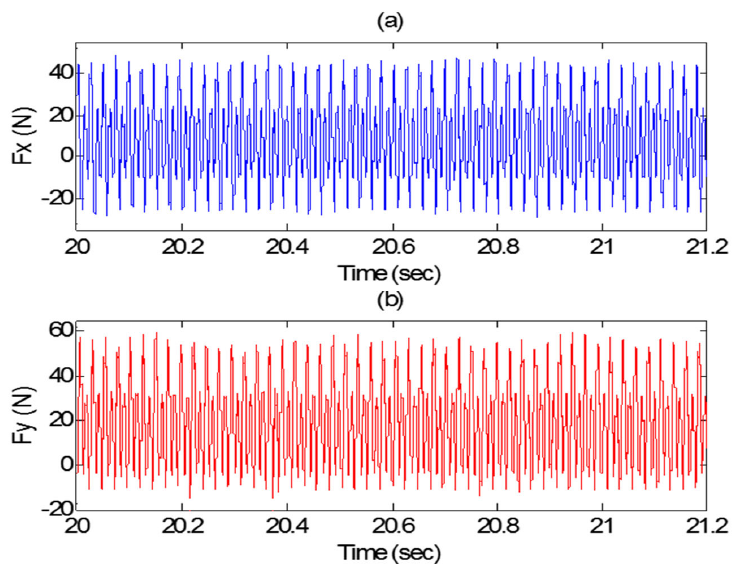
Figure 2. Measured cutting force signal at a feed rate of 0.03 mm/tooth in the ( a ) x ‐ direction and ( b ) y ‐ direction.